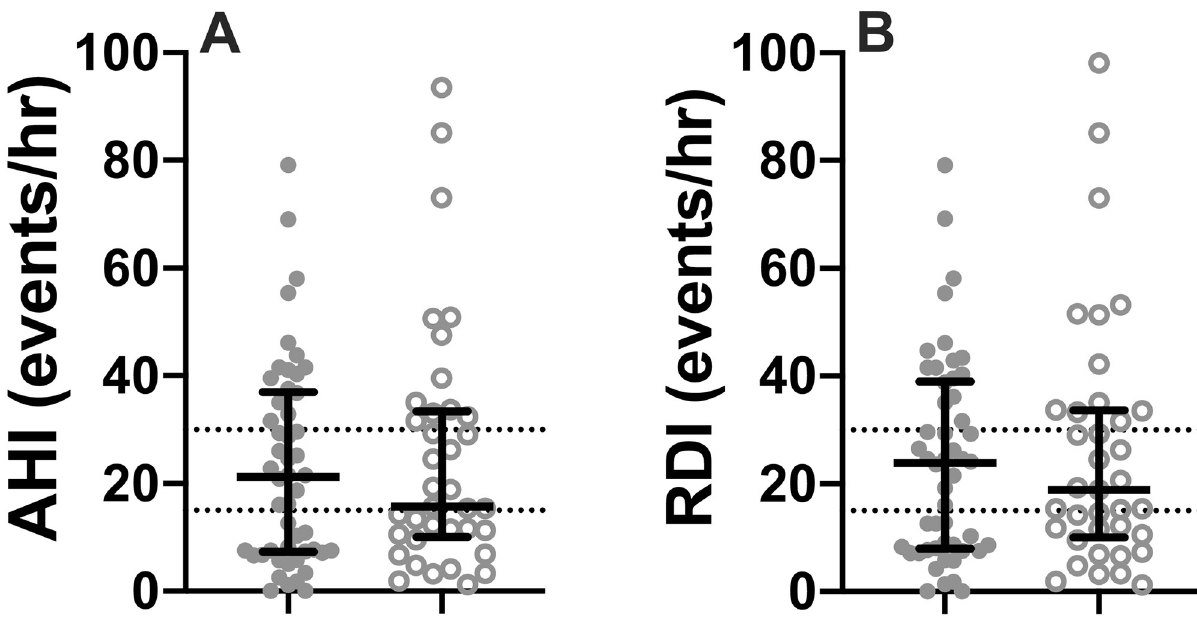
Fig 1. Individual data for breast cancer and endometrial cancer patients for: (A) apnea hypopnea index (AHI) and (B) respiratory disturbance index (RDI). Bars represent median and interquartile range, dotted lines are at 15 events/hour (moderate OSA) and 30 events per hour (severe OSA), closed circles are breast cancer patients, open circles are endometrial cancer patients.